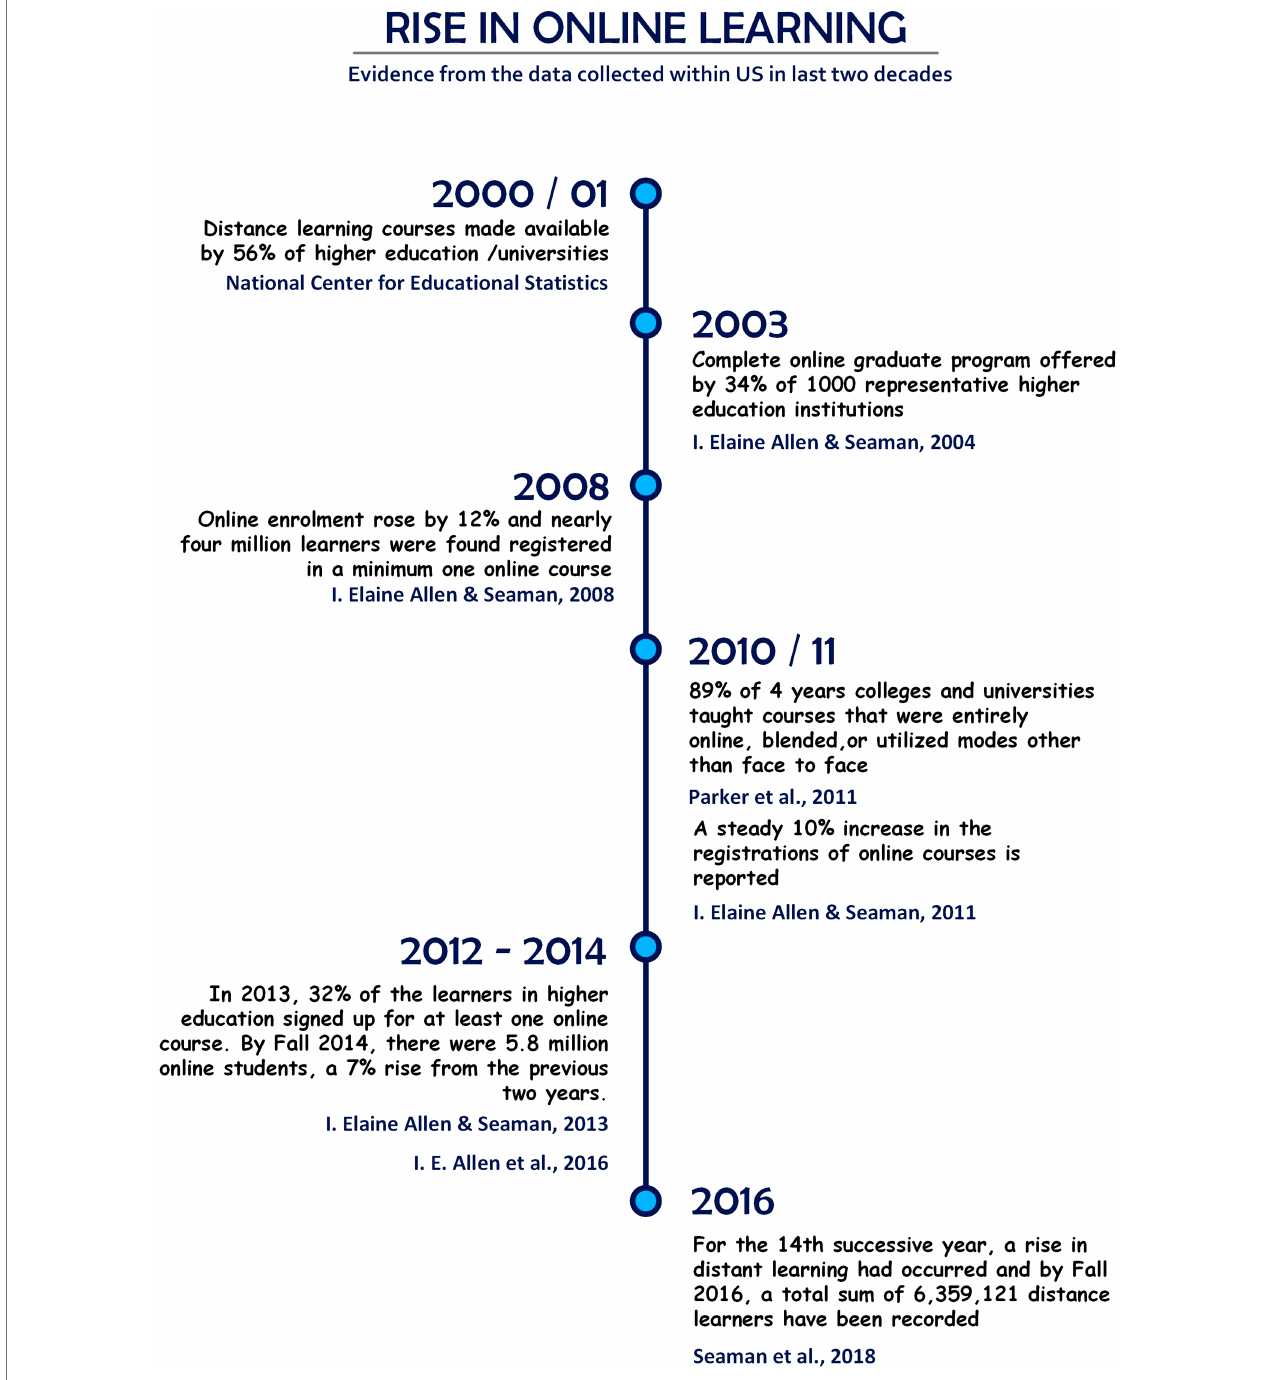
FIGURE 1 | Rise in online learning in the United